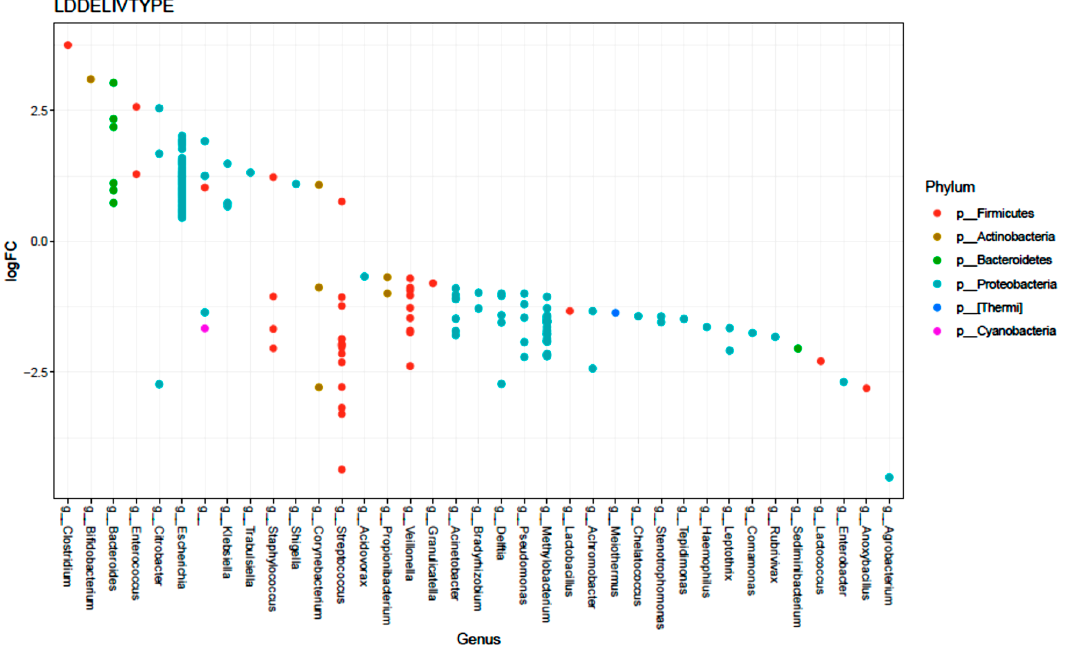
Figure 4. Differentially abundant OTUs (FDR < 0.05) according to delivery mode (negative log fold change (logFC) indicates OTU is enriched in meconium from CS infants, positive logFC indicates OTU is enriched in meconium from VD infants).